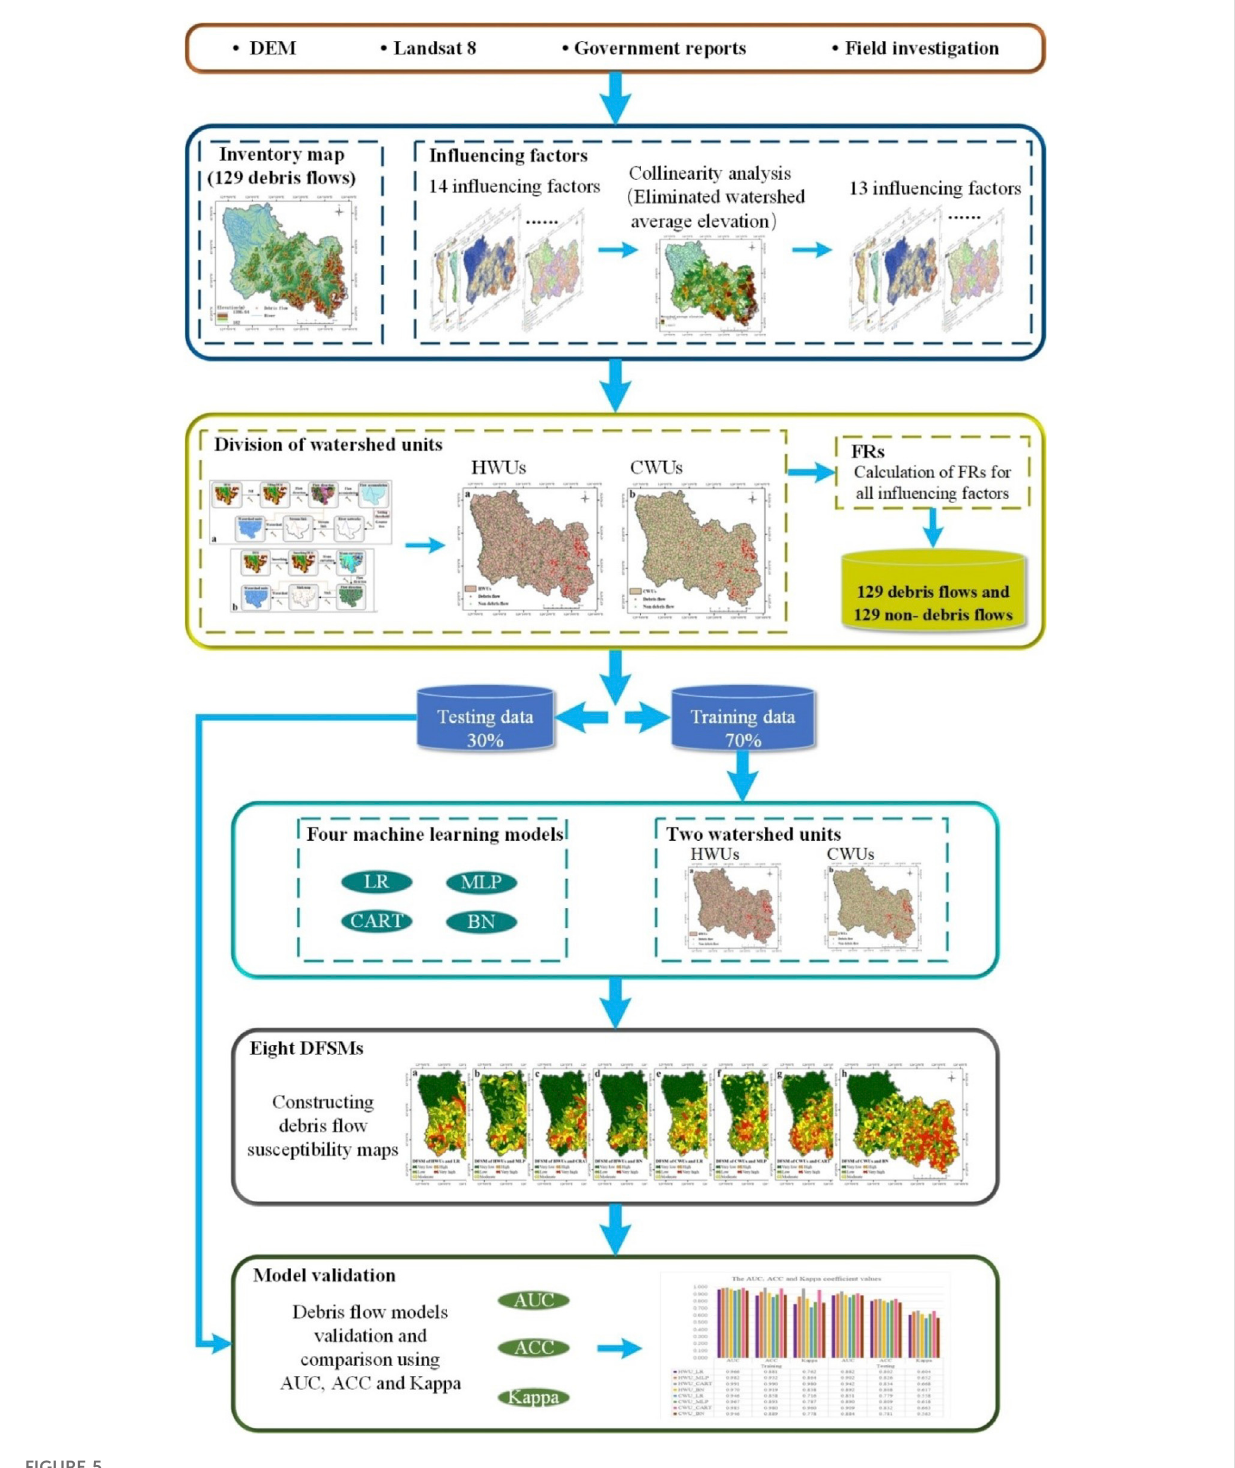
FIGURE 5 Flowchart of the research